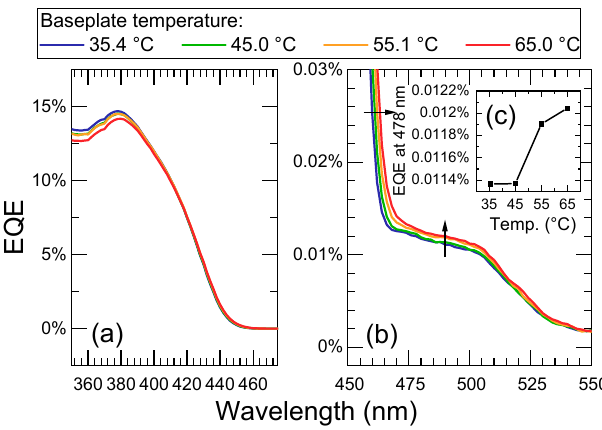
Figure 2. External quantum efficiency of the device at various wavelength ( a , b ) and external quantum efficiency at 478 nm at various baseplate temperatures ( c ).